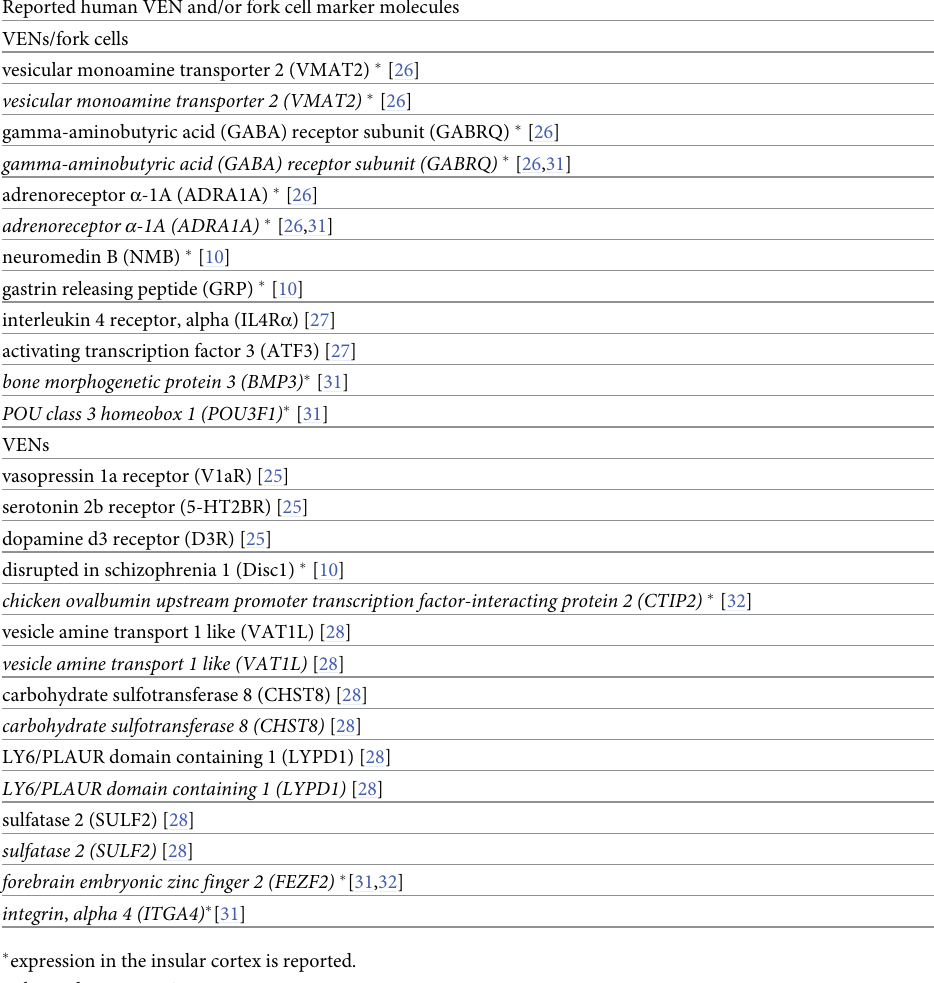
Reported human VEN and/or fork cell marker